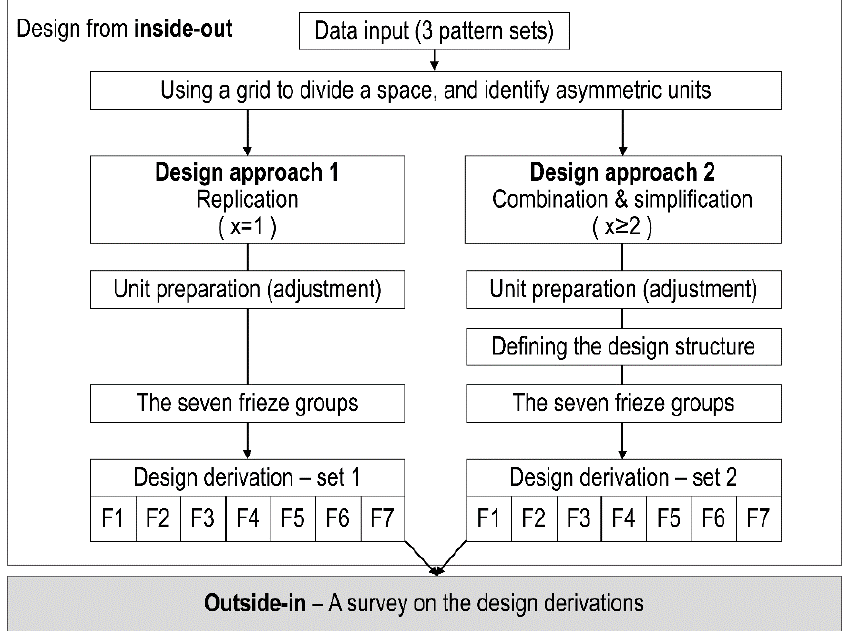
Figure 4. Research methodology. (Illustration by Kunkhet and Chudasri).